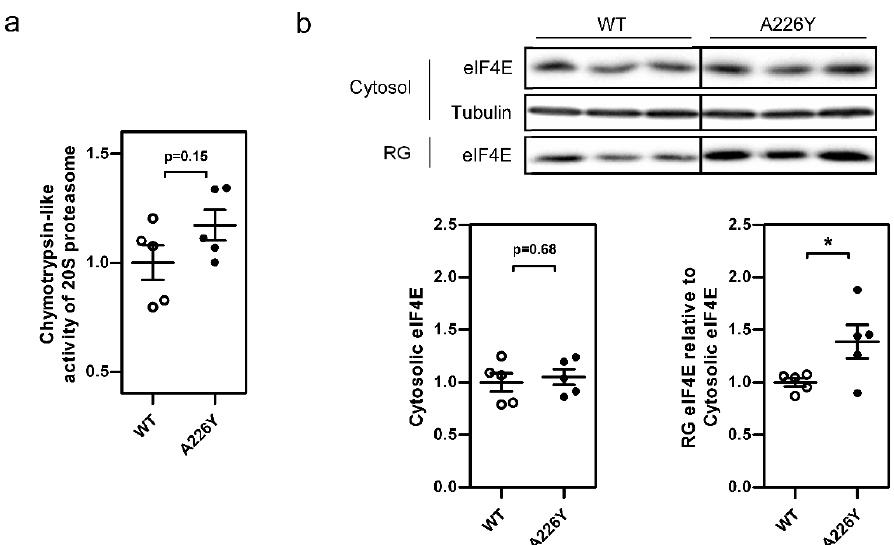
Figure 2. Proteasome activity and stress granule formation in the liver of mistranslating A226Y mice. ( a ) Chymotrypsin-like activity of the 20S proteasome in WT and A226Y liver ( N = 5). ( b ) eIF4E protein